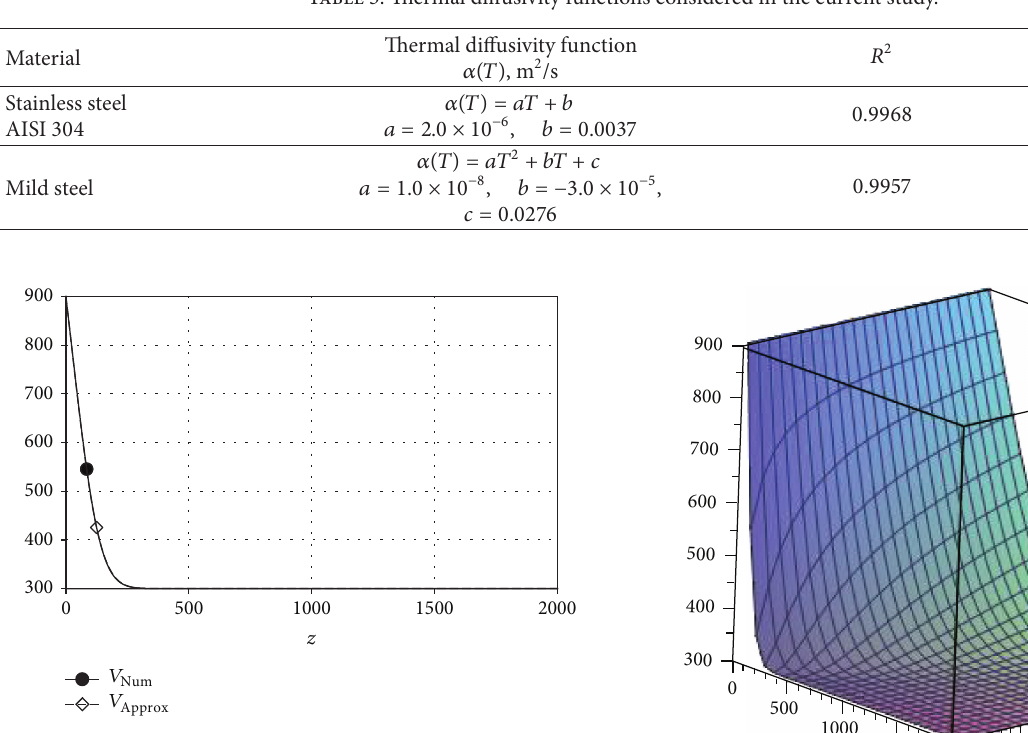
and numerical Approx Figure 6: Approximate analytic solution 𝑇(𝑥,𝑡) of the IBVP (8),